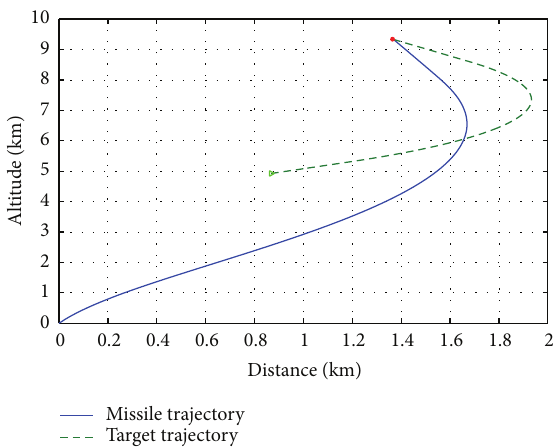
Figure 11: Angle trajectories for gimbaled system (Case 2).